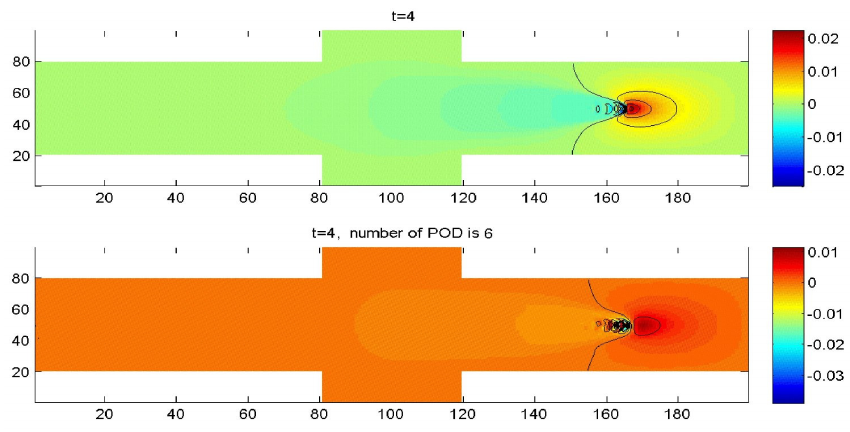
Figure 6. Top chart is the classical SCNMFE solution of velocity u and bottom chart is the POD-based reduced-order SCNMFE solution of velocity u with 6 POD bases when Re = 1000 and Pr = 7 at time t = 4.